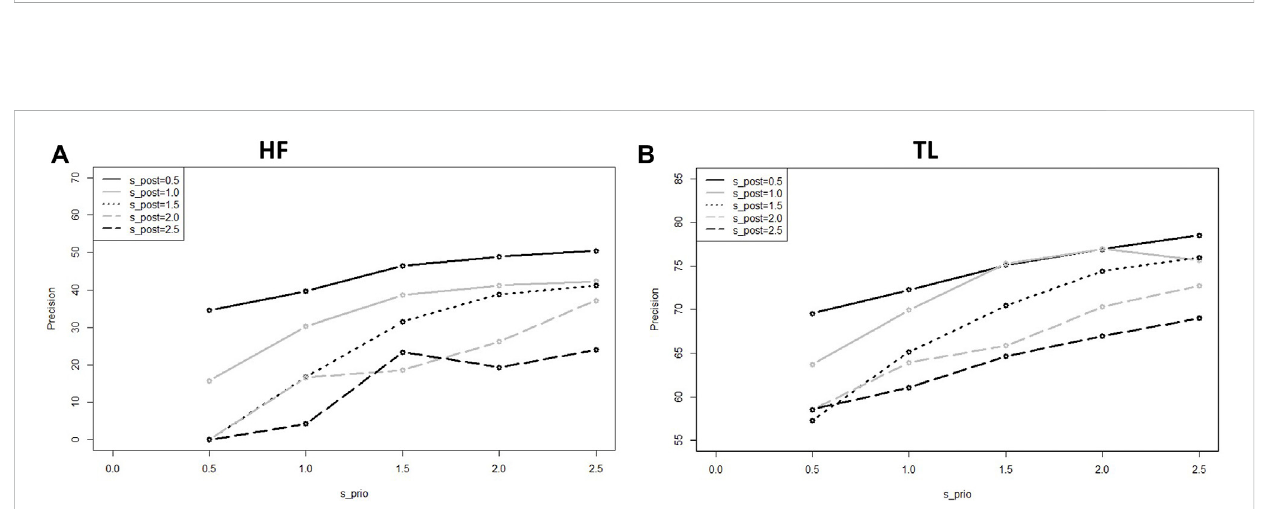
FIGURE 9 Computed precision of the BaLONNs for HF (A) and TL (B) and different standard deviations; σ pr ( x -axis), and σ po (different